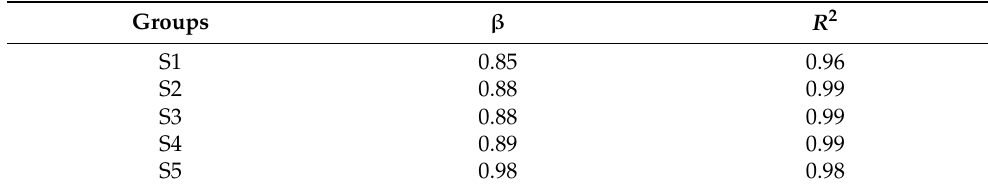
Figure 6. Percentage of okra root dry mass for each soil layer in relation to root weight density. Table 3. Root distribution coefficient ( β , dimensionless) of okra in different root weight density